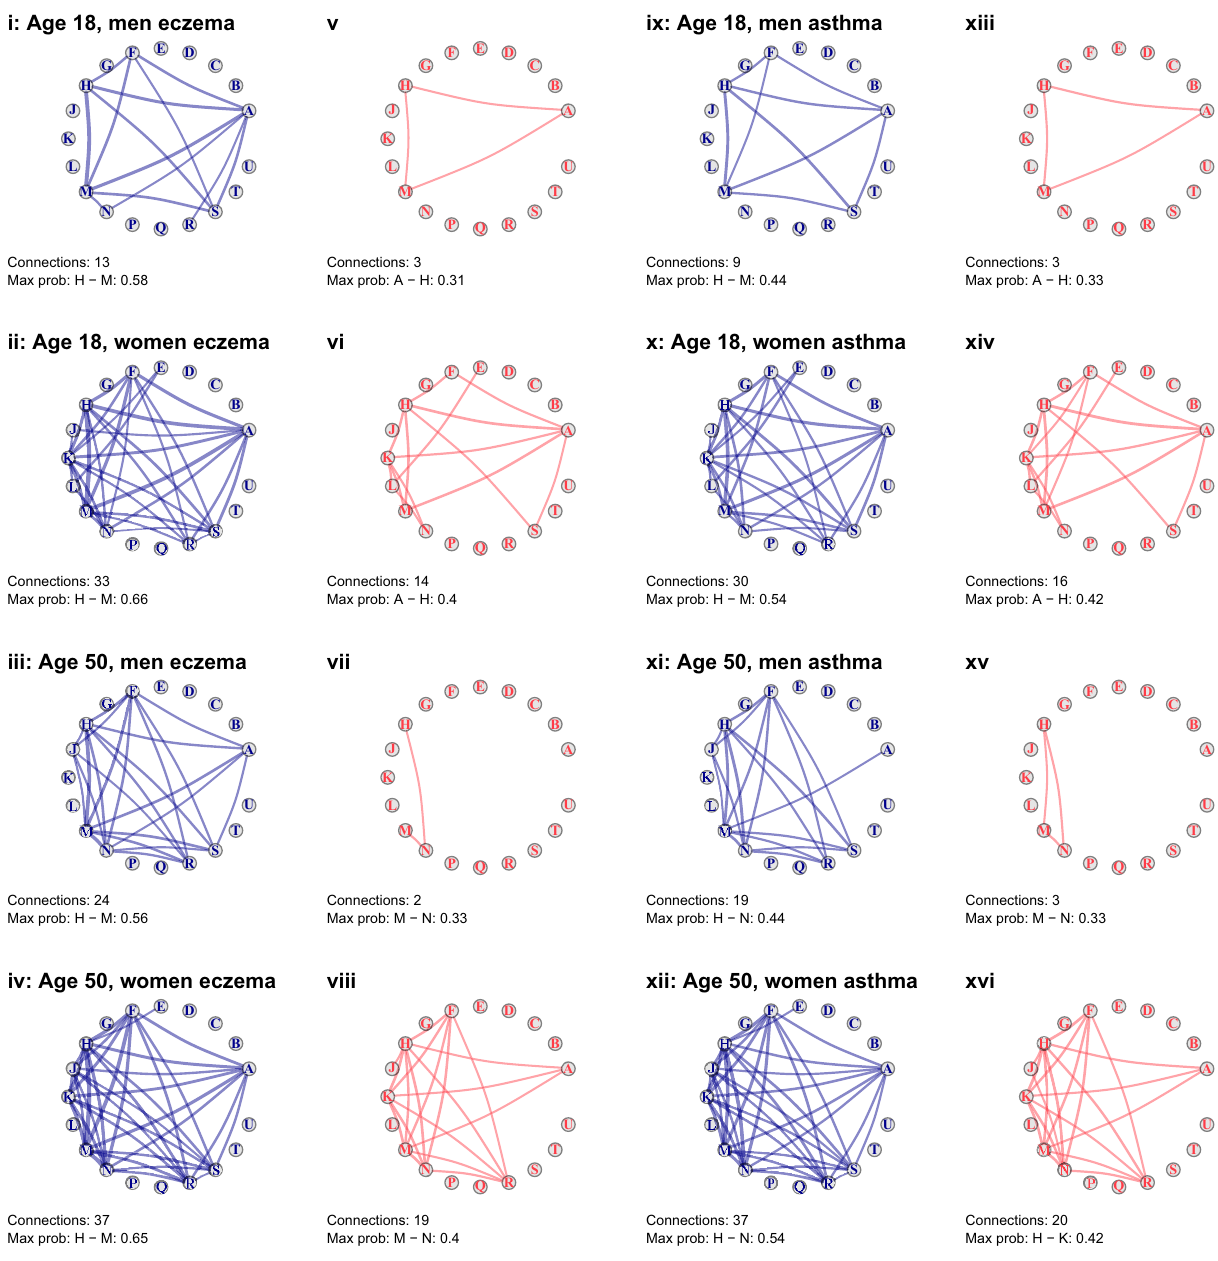
Figure 2. Undirected networks of Read code chapter diagnoses in people with eczema (A–D), without eczema (E–H), with asthma (J–M) and without asthma (N–Q). Edges displayed are those that represent ≥ 30% probability of Read code chapter recording co-occurrence within 5 years. A: Infectious/parasitic diseases, B: Neoplasms, C: Endocrine/metabolic, D: Blood diseases, E: Mental disorders, F: Nervous system/senses, G: Circulatory system, H: Respiratory system, J: Digestive system, K: Genito-urinary system, L: Pregnancy/ childbirth, M: Skin/subcutaneous, N: Musculoskeletal, P: Congenital anomalies, Q: Perinatal conditions, R: Ill- defined conditions, S: Injury/poisoning, T: Causes of injury/poisoning, U: External